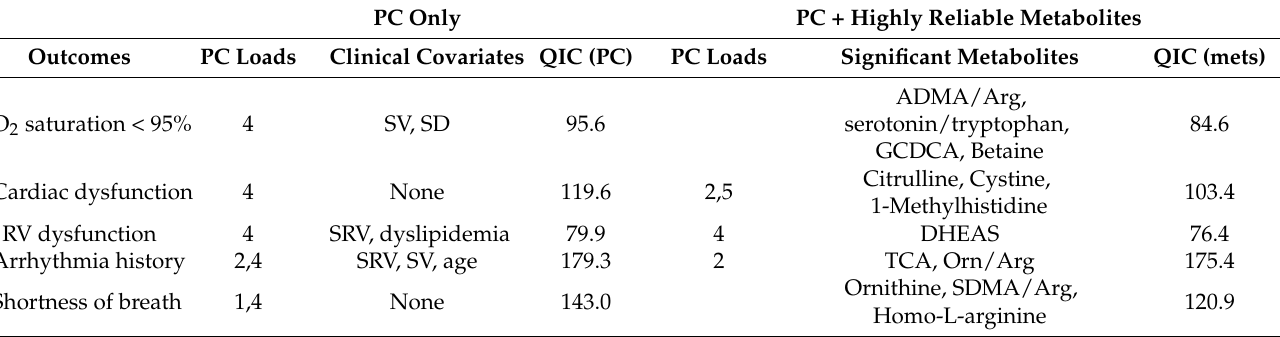
Table 4. Multivariable models. Association between principal components loads, individual metabolites with high reliability in bootstrap resampling and adverse cardiac outcomes. Left side—regression models built with PC loads and clinical covariates only, reported are the variables included in the final regression model. Right side—regression models built with PC loads and clinical covariates (if statistically significant) and the highly reliable